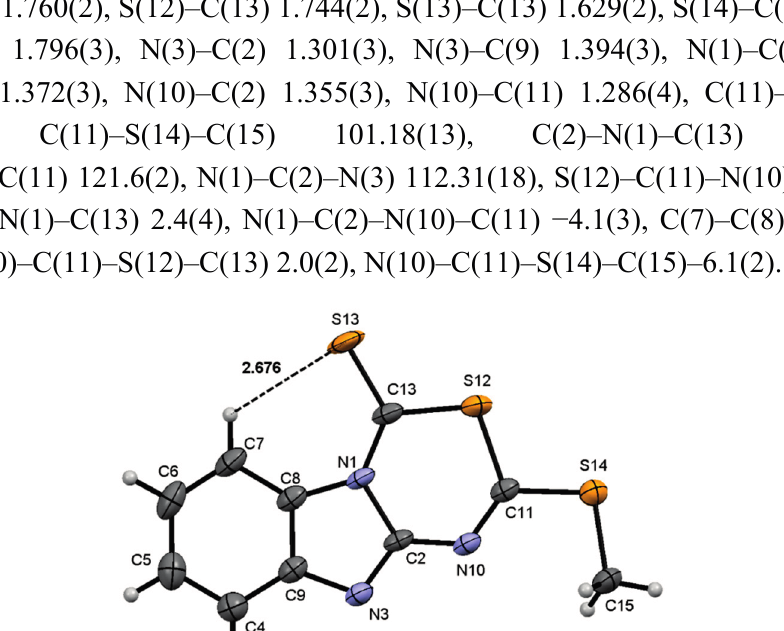
Figure 4. Molecular structure of compound 7 . Selected bond lengths (Å) and angles (°):